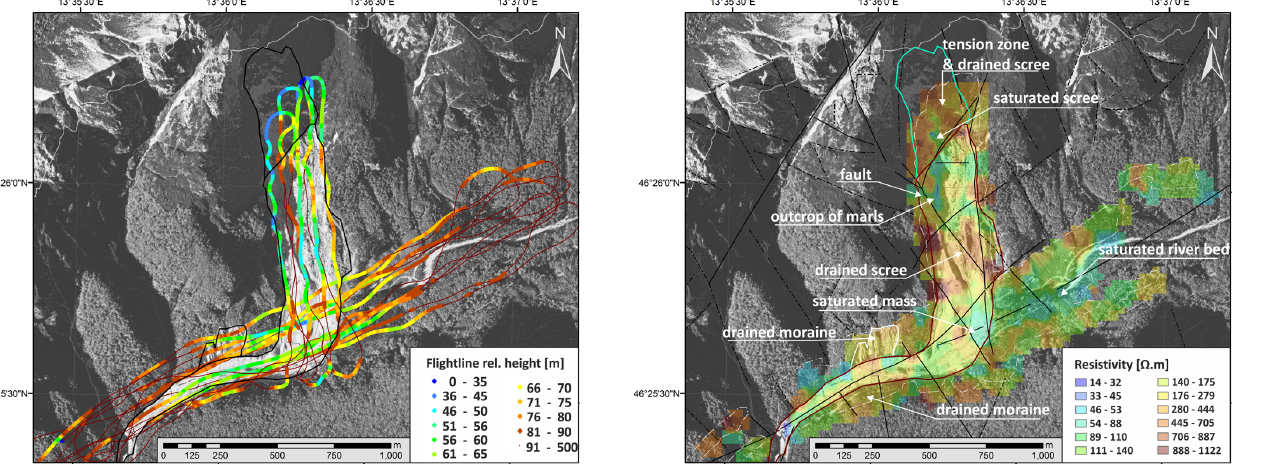
Fig. 3. Map of the flight lines over the test area at the Stože land- slide, with indicated relative altitudes of the AEM sensor above the ground surface; note the altitudes over 90m, which are unsuitable for the survey (Source of data: Geological Survey of Austria and Google Earth).